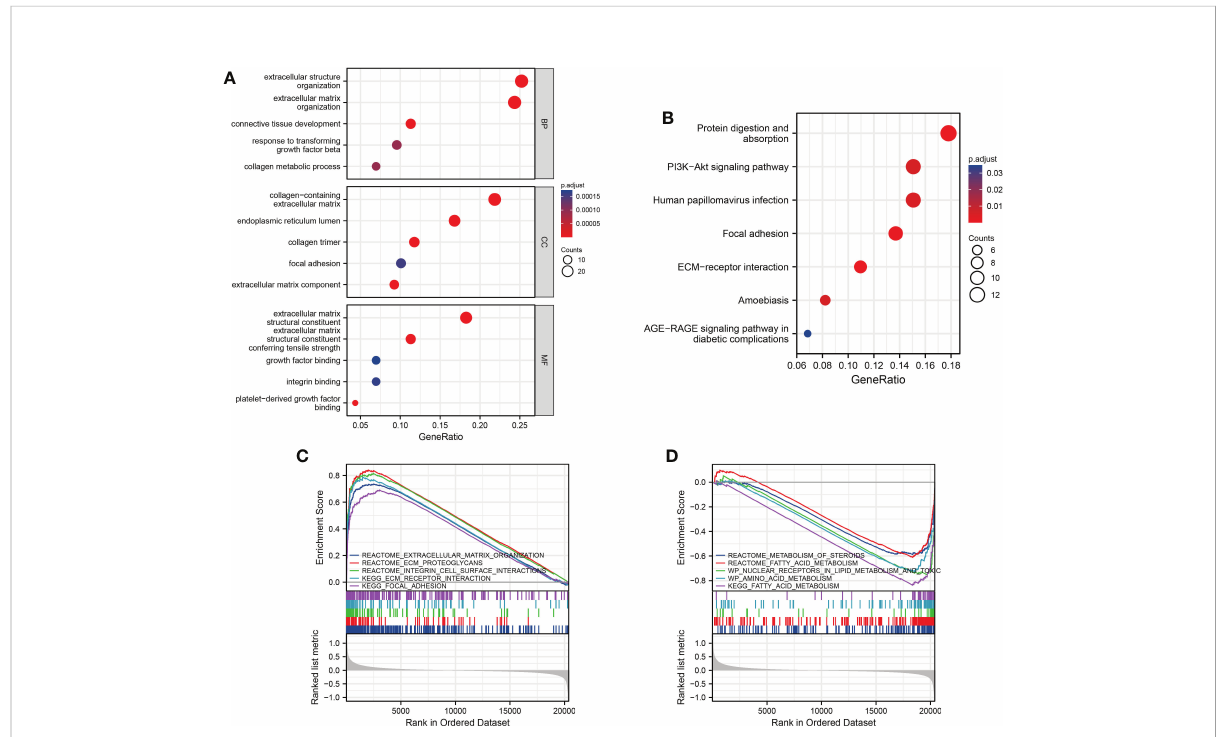
FIGURE 5 Functional analysis and the enriched immune cells between the high- and low-risk groups. (A, B) GO and KEGG analysis between different risk groups (BP, biological processes; CC, cellular components; MF, molecular functions; the darker the red means the more signi fi cant the difference; larger bubbles mean more enriched genes). (C, D) GSEA to investigate the biological pathways enriched in the high- and low-risk